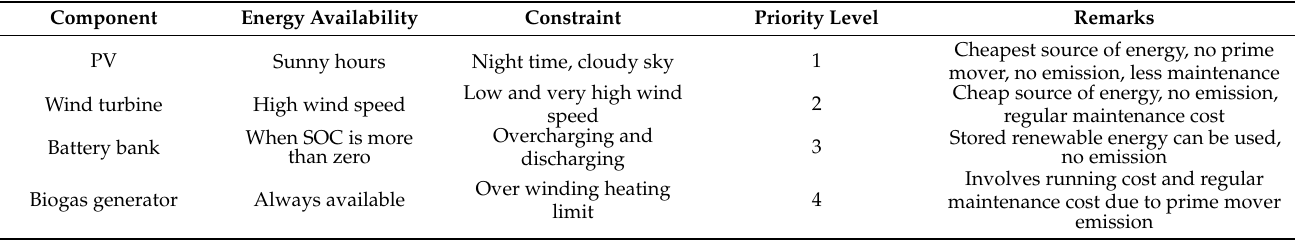
Table 5. Priority of operation of different energy